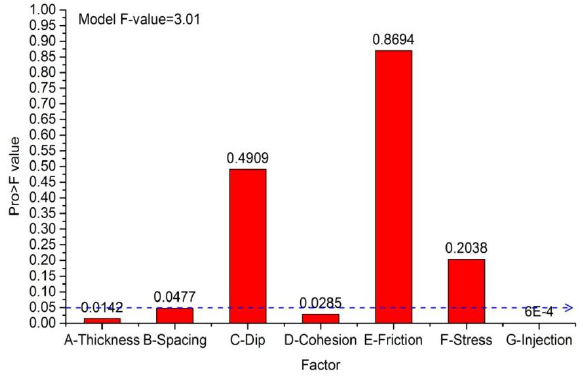
Figure 7. Anovafor SLA response surface with linear model.